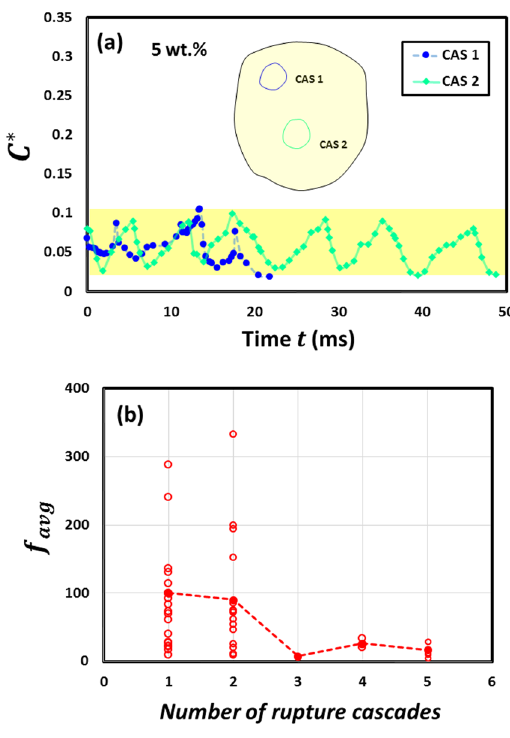
Figure 7. Time evolution of global oscillatory response parameters for a 5 wt.% gelled ethanol fuel droplet undergoing burning. ( a ) Variation of circumferential strain ∆ = ⁎ C C C ( / ) across different oscillatory rupture 1 cascades. ( b ) Average bursting frequency = f of the droplet as a function of cascade avg ∑ + t t N ( ) / N a ia